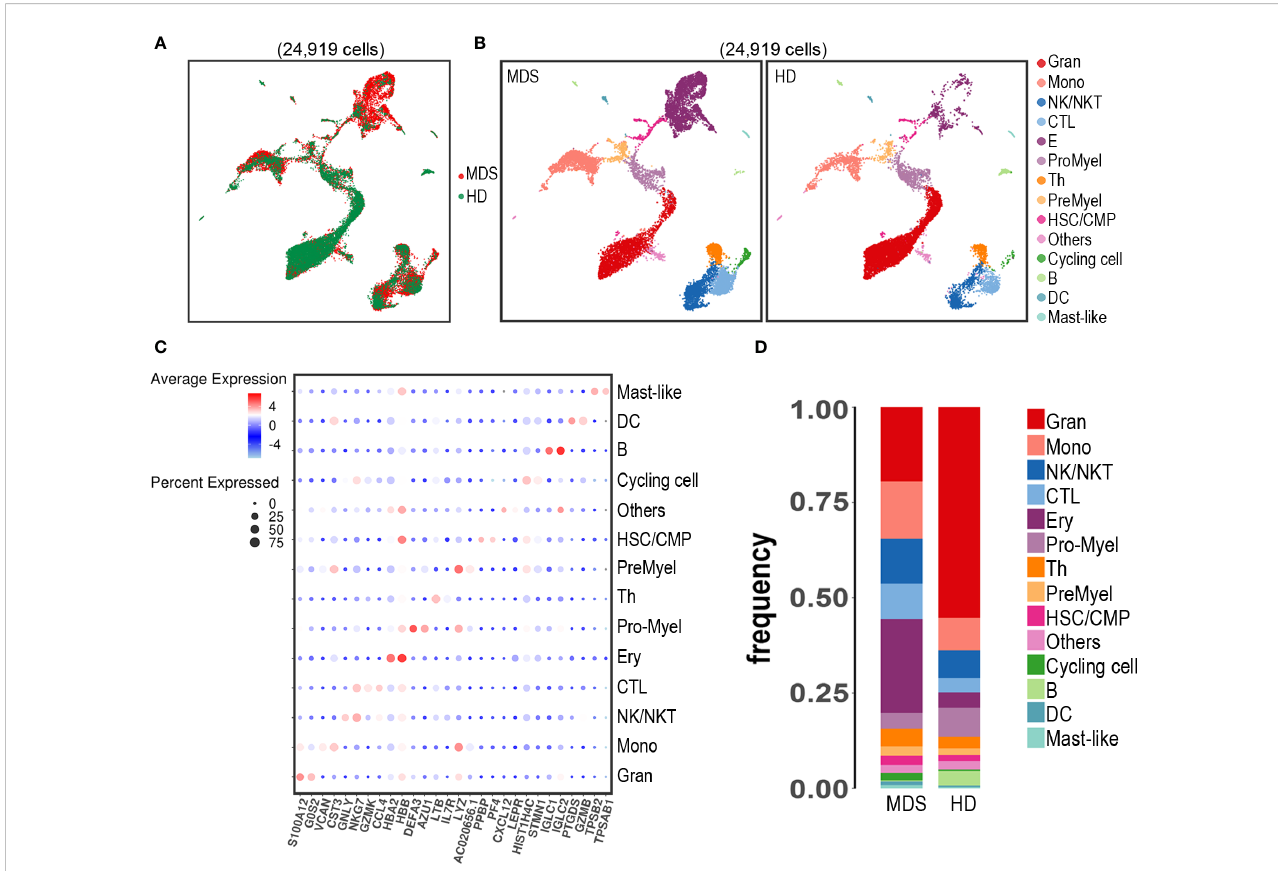
FIGURE 2 Identi fi cation of cell populations in BM samples from patient 1 developing tMDS after CAR T therapy and an age-matched HD using scRNA-seq. UMAP projection of scRNA-seq data for 24,919 hematopoietic cells from patient 1 and HD based on 10 principal component analysis consolidations and the 1,000 most variable genes in the data set. (A) t-SNE plot of all the 24,919 single cells from tMDS patient and HD. Each dot represents a single cell; the dot colors indicate source of donors. (B) t-SNE plot of all the 24,919 single cells colored by predicted hematopoietic populations in tMDS patient and HD. Cells were annotated based on known linease-speci fi c marker genes. (C) Dot plot of differentially key cell-type marker genes. (D) Stacked barplots show the frequencies of 14 cell types in bone marrow from tMDS patient and HD, colored based on cell